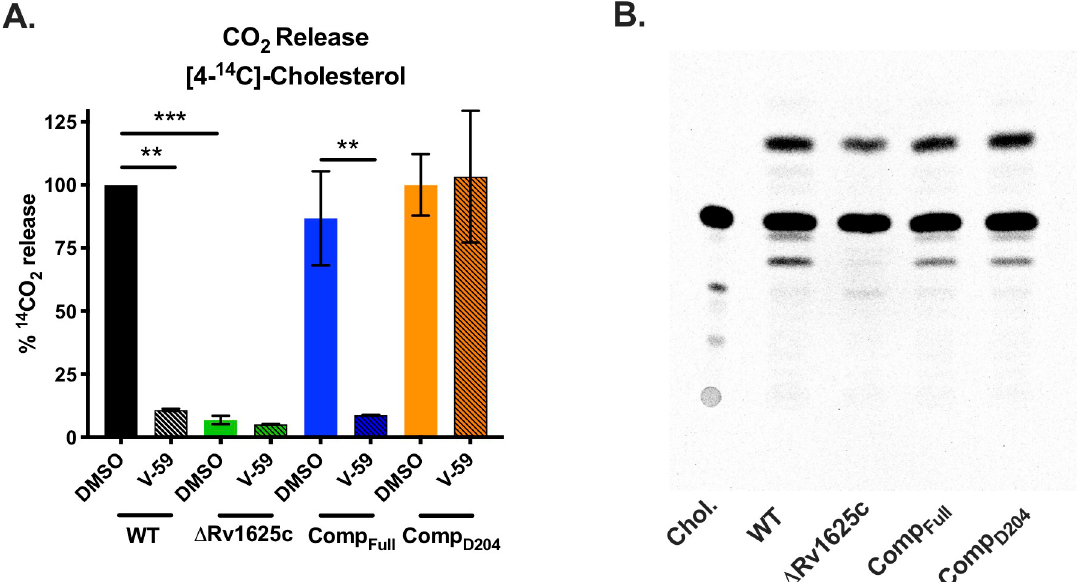
Fig 4. The transmembrane domain of Rv1625c is essential for complete degradation of cholesterol and the catalytic domain of Rv1625c is required for V-59 activity. ( A ) Catabolic release of 14 CO 2 from [4- 14 C]-cholesterol in WT, Δ Rv1625c, Comp Full , and Comp D204 strains treated with V-59 (10 μ M) or DMSO vehicle control. Data are from two experiments with three technical replicates, normalized to OD and quantified relative to WT treated with DMSO. Shown as means ± SD ( �� P < 0.01, ��� P < 0.001, Two-way ANOVA with Tukey’s multiple comparisons test). ( B ) TLC comparing [4- 14 C]-cholesterol-derived metabolites extracted from supernatants of Mtb. Image is representative of two experiments. Equivalent counts were spotted per lane. “Chol.” = [4- 14